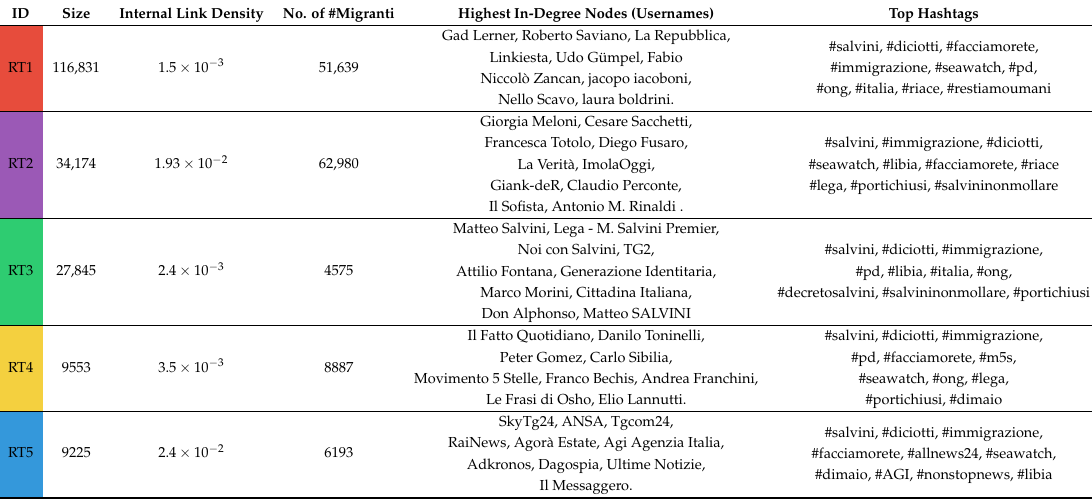
Table 4. Table describing the communities of the RT network in terms of sizes, density, number of posts with hashtag “migranti”, top 10 nodes for in-degree centrality and top 10 most used hashtags (excluding